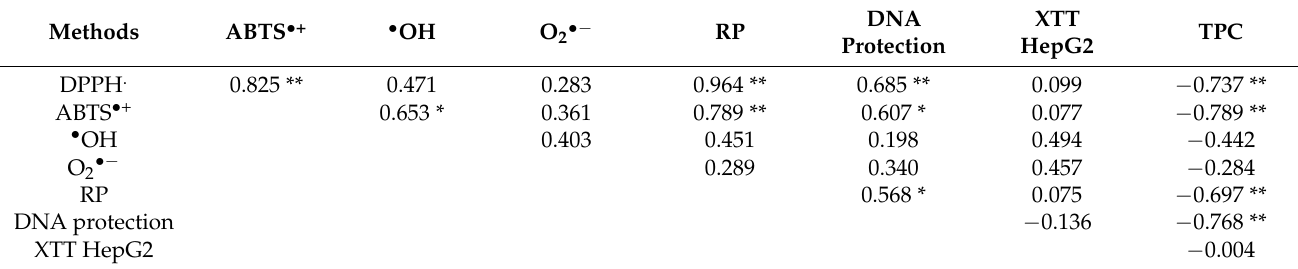
Table 3. Correlation coefficient (r) values estimated from correlation analysis between values of macroal- gae extracts in DPPH . , ABTS • + , • OH, O 2 •− , RP, DNA plasmid strand cleavage (DNA protection), XTT, and TPC